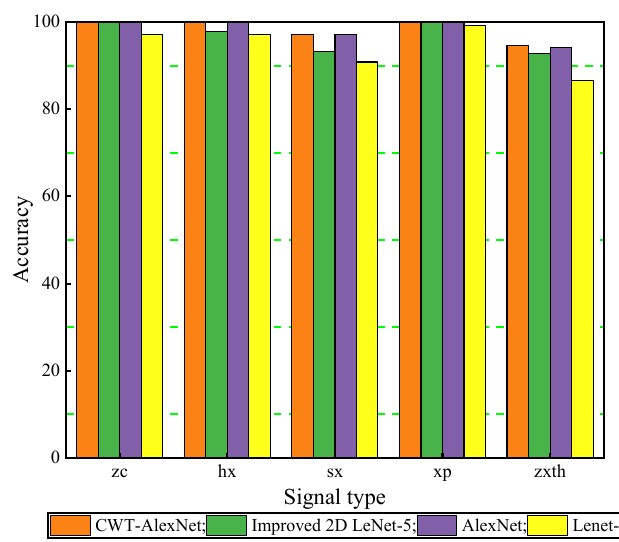
Figure 11. Histogram of the classification results for different state signals.